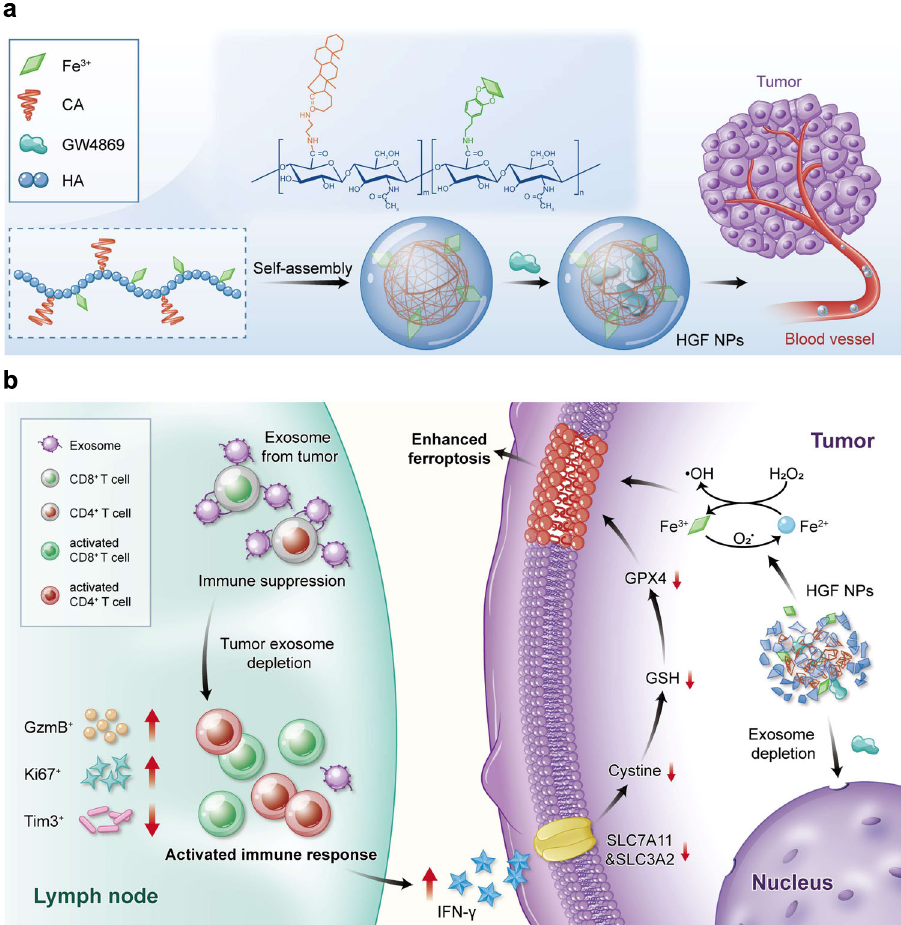
Fig. 1 Schematic illustration of HGF-relevant preparation and therapeutic strategy. a The exosome inhibitor (GW4869) with ferroptosis inducer (iron ion) were uni fi ed into a HA (hyaluronic acid) based nanoplatform (HGF NPs). b With intravenous administration released GW4869 from HGF NPs signi fi cantly decreased tumor-derived exosome generation, resulting in activated anti-tumor immune response and a robust memory response against tumor cells. Furthermore, re-activated T cells released a high level of IFN- γ (interferon- γ ) cytokine to downregulate the expression of SLC7A11 and SLC3A2, both of which are responsible for the synthesis of intracellular anti-oxidant cystine, enhancing the ferroptosis induced by an enriched iron source from HGF